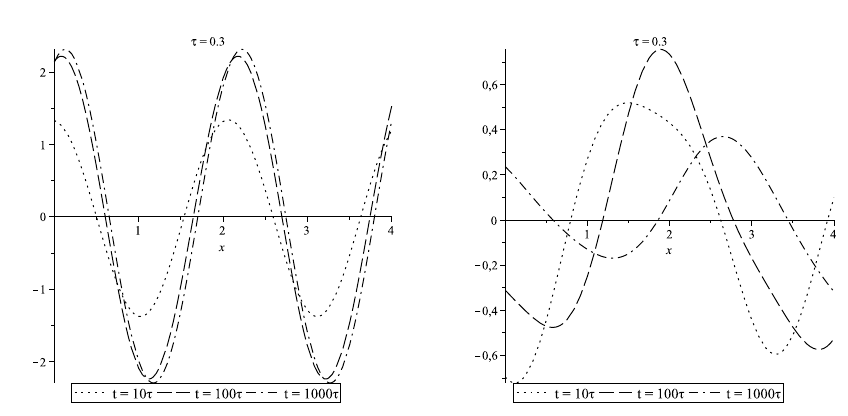
Figure 2. Profiles of waves u,v at time moment τ = 0